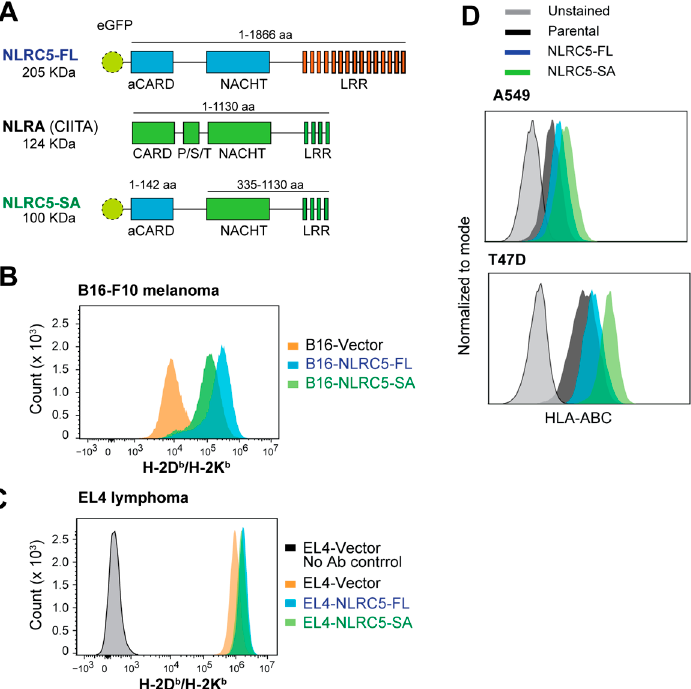
Figure 1. MHC-I induction by NLRC5-SA in mouse and human cancer cell lines. ( A ) The NLRC5-SA construct. NLRC5 superactivator (NLRC5-SA) was generated by fusing the N-terminus atypical CARD (aCARD) domain of full-length human NLRC5 (NLRC5-FL) to the central NACHT and C-terminus LRR regions of NLRA (CIITA), thereby retaining its tripartite structure. ( B ) Cell surface MHC-I expression in mouse B16.F10 melanoma cells stably expressing control vector, NLRC5-FL or NLRC5-SA expression vectors evaluated by flow cytometry using a bi-specific H-2Kb/Db antibody. ( C ) MHC-I expression in mouse EL4 lymphoma cells expressing control vector, NLRC5-FL or NLRC5-SA expression constructs. ( D ) Cell surface expression of HLA-ABC in A549 lung cancer and T47D breast cancer cell lines stably expressing NLRC5-FL or NLRC5-SA labeled with a pan-HLA antibody.